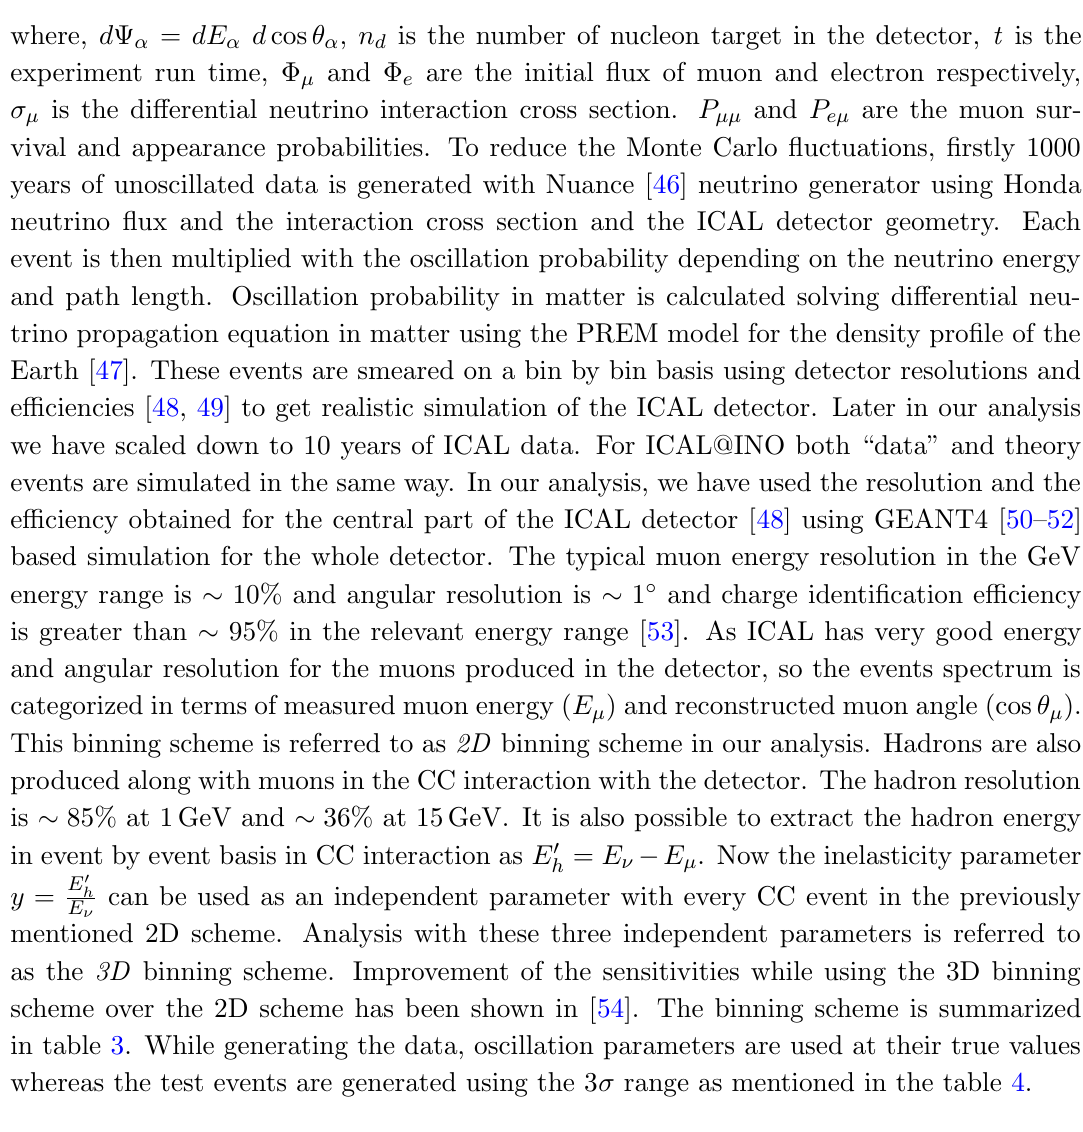
and P are the muon sur- (cid:22)(cid:22) e(cid:22)